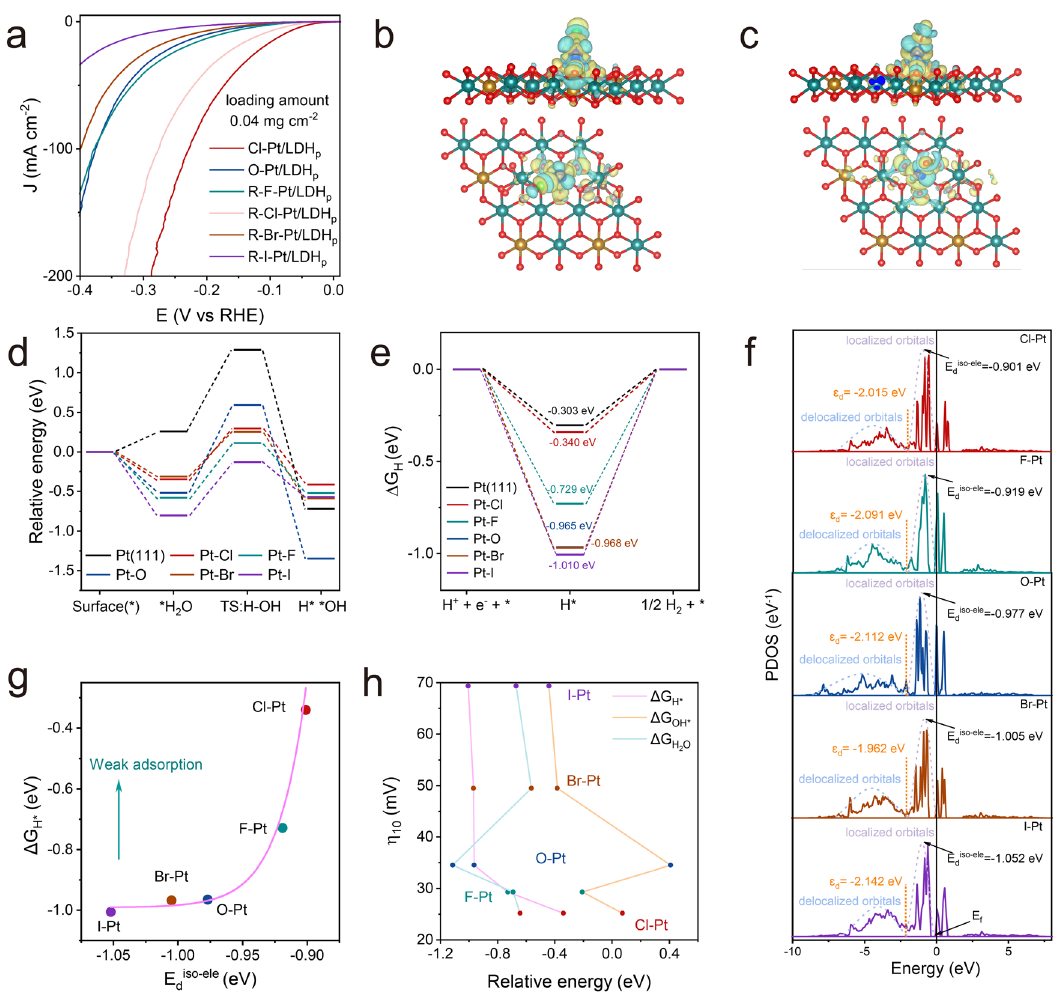
f CalculatedPt5dbandstructuresofthePt-SACs. g RelationshipbetweentheE d iso-ele and Δ G H* . h Relationship between alkaline HER overpotentials (at 10mAcm − 2 ) and variables. The Pt loading amount of Cl-Pt/LDH p , HO-Pt/LDH p , R-F-Pt/LDH p , R-Cl-Pt/ LDH p ,R-Br-Pt/LDH p andR-I-Pt/LDH p is2.88×10 − 4 ,2.88×10 − 4 ,2.84×10 − 4 ,3.00×10 − 4